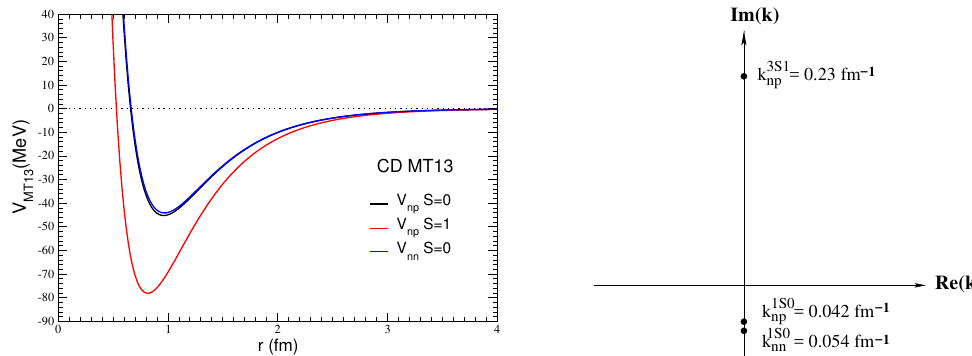
Figure 2: S-wave V in the different spin an isospin channels (left) and singularities nN of the corresponding scattering amplitude in the complex momentum plane (right).